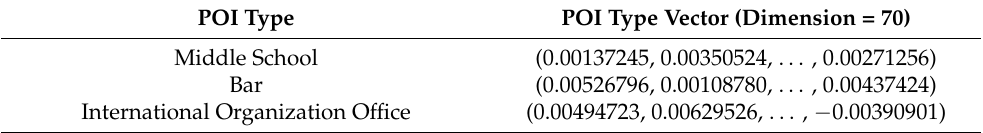
Table 4. Examples of POI type